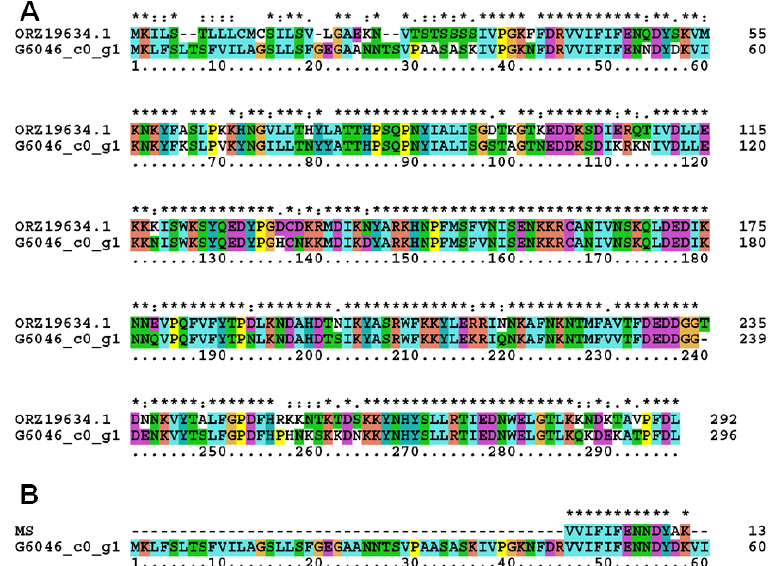
Figure 3. Amino acid sequence alignment. ( A ) Comparison of the amino acid sequence of ORZ19634.1 and G6046_c0_g1. ( B ) One amino acid sequence, VVIFIFENNDYAK, of MS results was matched with the amino acid sequence encoded by the G6046_c0_g1 gene. * indicates positions which have a single, fully conserved residue, : indicates that one of the following “strong” groups is fully conserved.